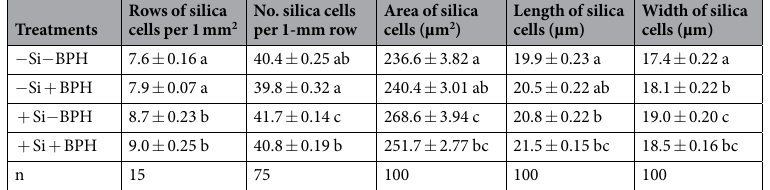
Table 1. Effects of Si amendment and Nilaparvata lugens infestation on silicification of rice leaf sheaths. + Si = silicon amendment at 112 mg Si/L nutrient solution to rice plants, − Si = no silicon amendment. + BPH = infestation by N. lugens , − BPH = no infestation. Values are means ± SE (n, number of biological replicates). Different letters following the means in the same column denote significant difference at P < 0.05 via Tukey’s multiple range tests.